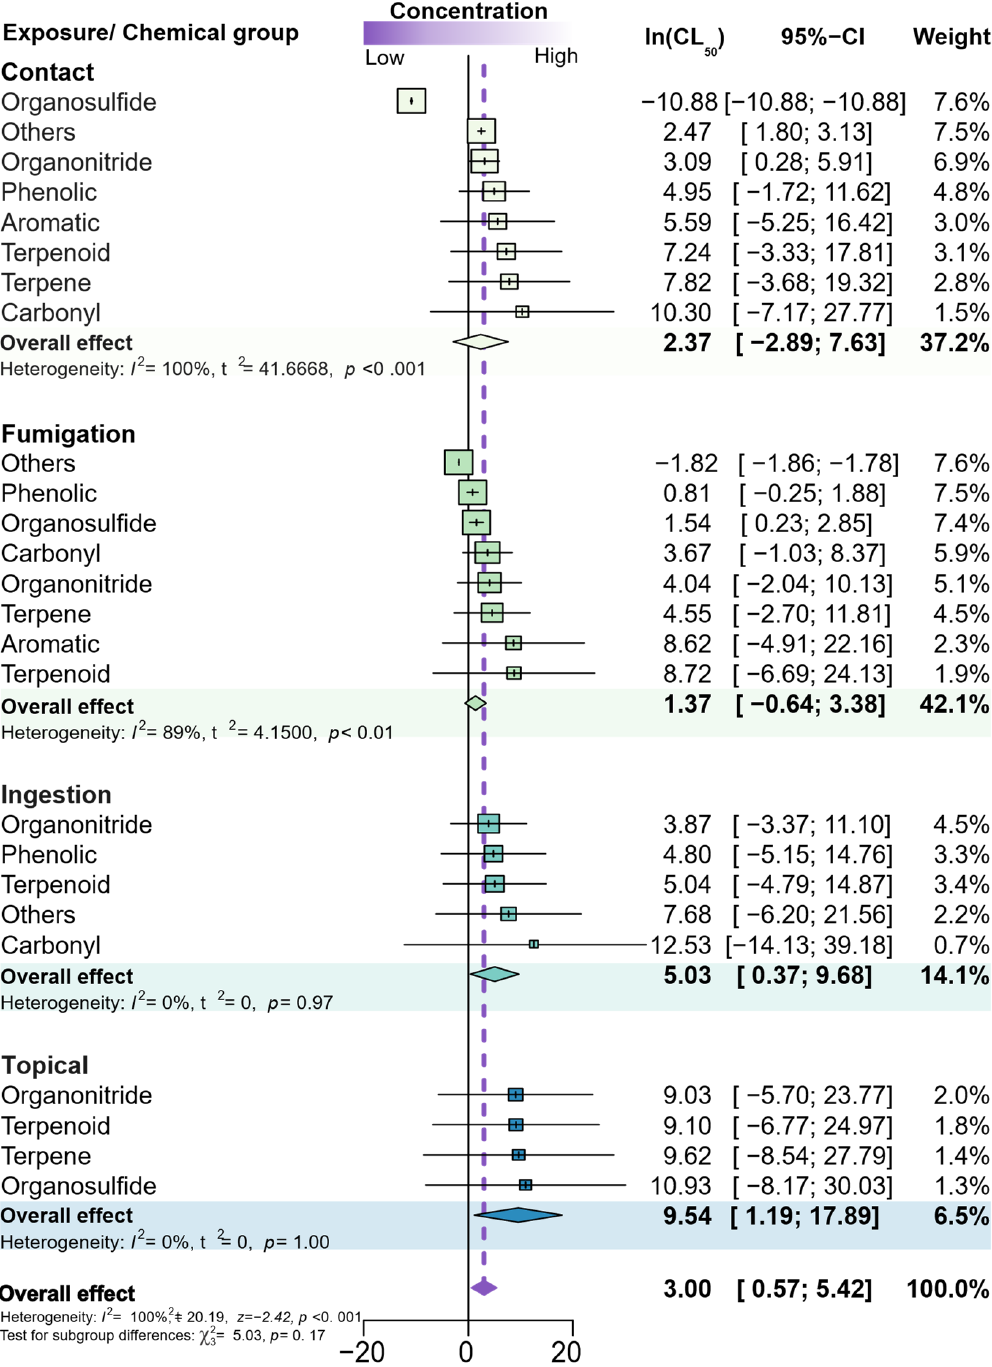
Figure 8. Forest plot summarizing the quantitative meta-analysis comparing the LC 50 s, as toxicity endpoints, in papers assessing the insecticidal activity of phytochemicals. The meta-analysis is divided into modes of exposure and phytochemical group. Concentrations (ppm) were transformed by natural logarithm. The average LC 50 s are denoted by boxes (horizontal lines), and the box size refers to the number of populations reported for the phytochemical group; the 95% CIs are represented by horizontal lines. The combined LC 50 estimate for overall trends is represented by a diamond, where the diamond width corresponds to 95% CI bounds. The vertical dashed line shows the overall estimated effect resulting from all species. The p -values for the heterogeneity test are indicated (number of papers = 84).